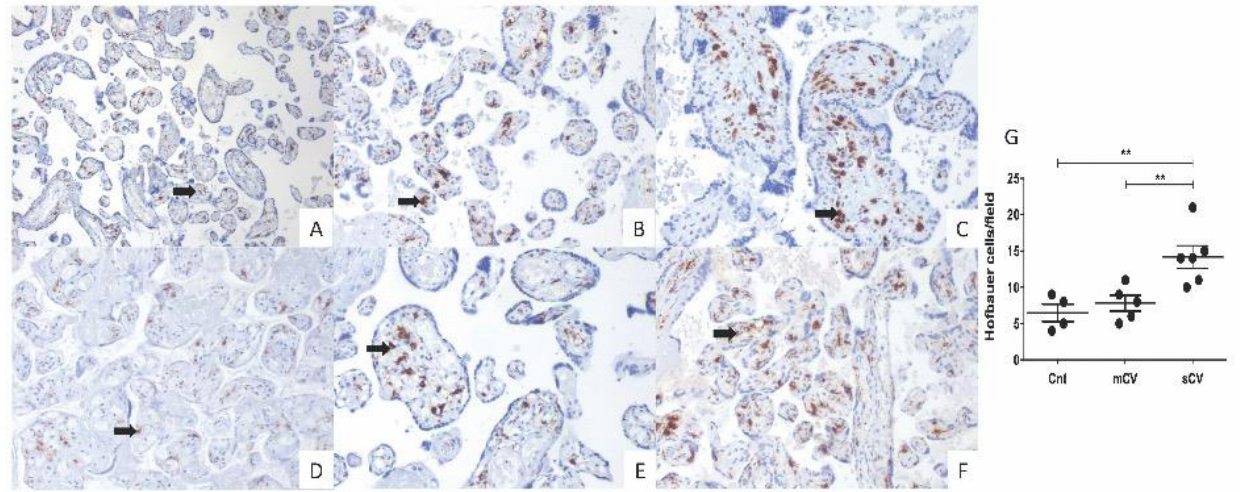
Figure 8. Placental chorionic villi from women with severe COVID-19 display a higher number of Hofbauer cells. Hofbauer cells (arrows) were detected with an antibody against CD68 and counterstained with hematoxylin. Representative 3 µm placental sections (20×) from control women ( A , D ), women with mild COVID-19 ( B , E ), and women with severe COVID-19 ( C , F ). ( G ) Quantification of Hofbauer cells in placentas from control women (Cnt), with mild COVID-19 (mCV), and severe COVID-19 (sCV). The number of Hofbauer cells was obtained by counting CD68+ positive cells in five optical fields per placenta. Each dot represents the mean of Hofbauer cells in five fields per placenta of each condition. Data are expressed as mean ± SD; F ANOVA test followed by Duncan’s multiple comparison test, ** p < 0.01.